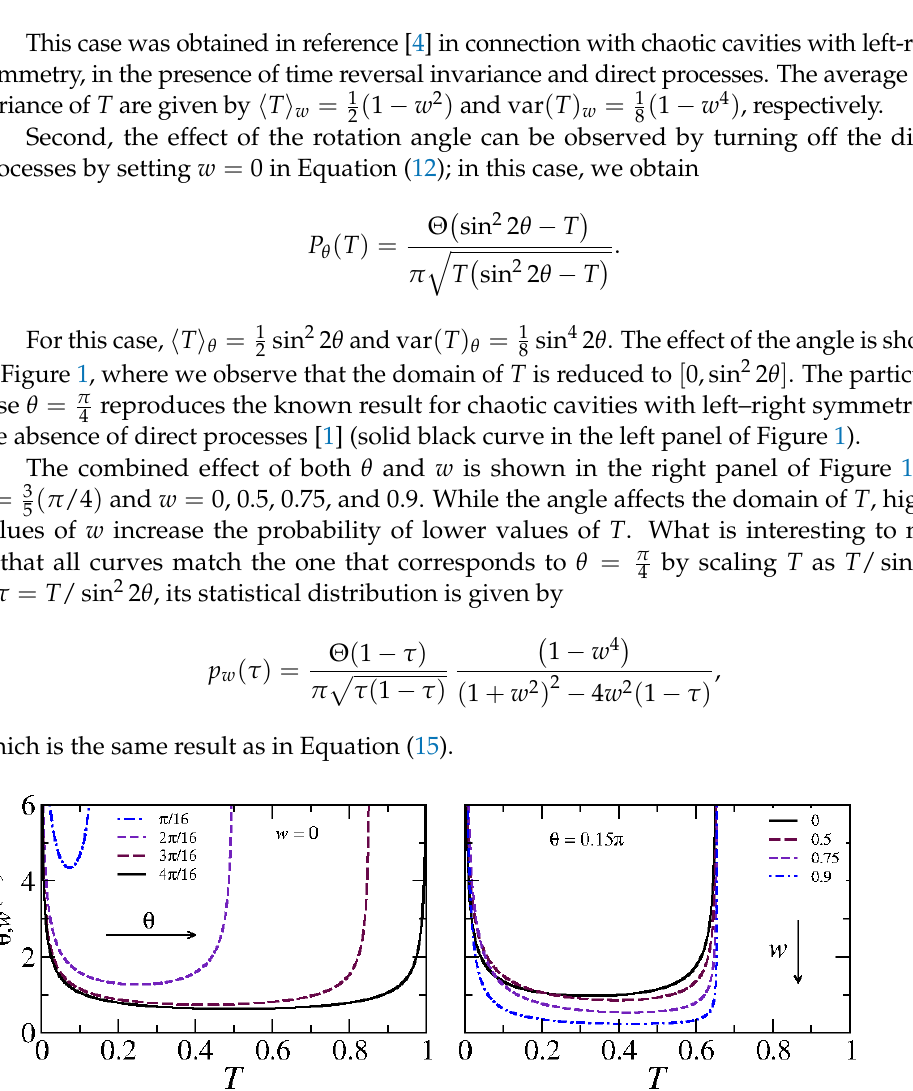
Figure 1. (Color online) Dimensionless conductance distribution P θ , w ( T ) for N = 1. (Left panel) P θ , w ( T ) in the absence of direct processes ( w = 0) for several values of θ . (Right panel) P θ , w ( T ) for ( π /4 ) , in the presence of direct processes: w = 0, 0.5, 0.75, and θ = 3 5